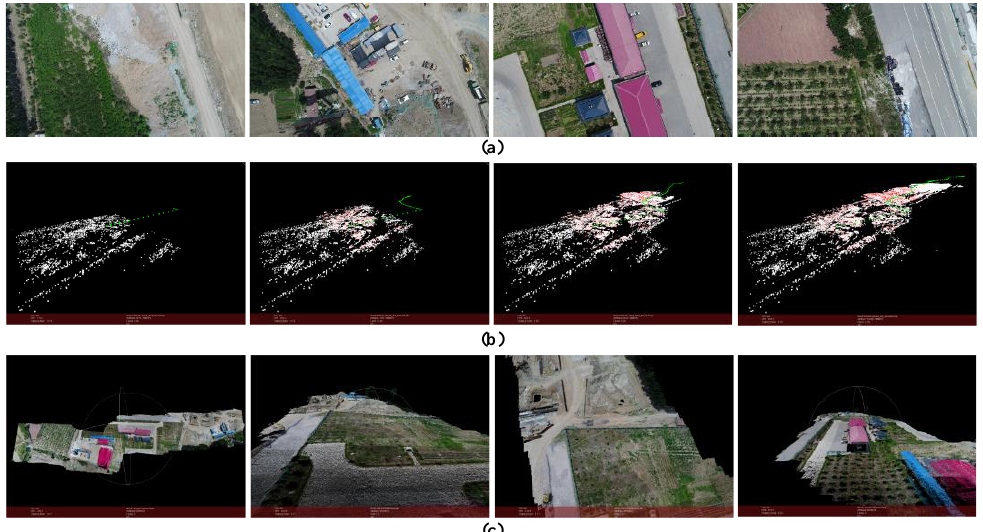
Figure 17. Reconstruction result of botanical garden. ( a ) Part of the images used for reconstruction; ( b ) Structure calculation of image queue SfM (green points represent the positions of camera); ( c ) Dense point cloud of the scene.